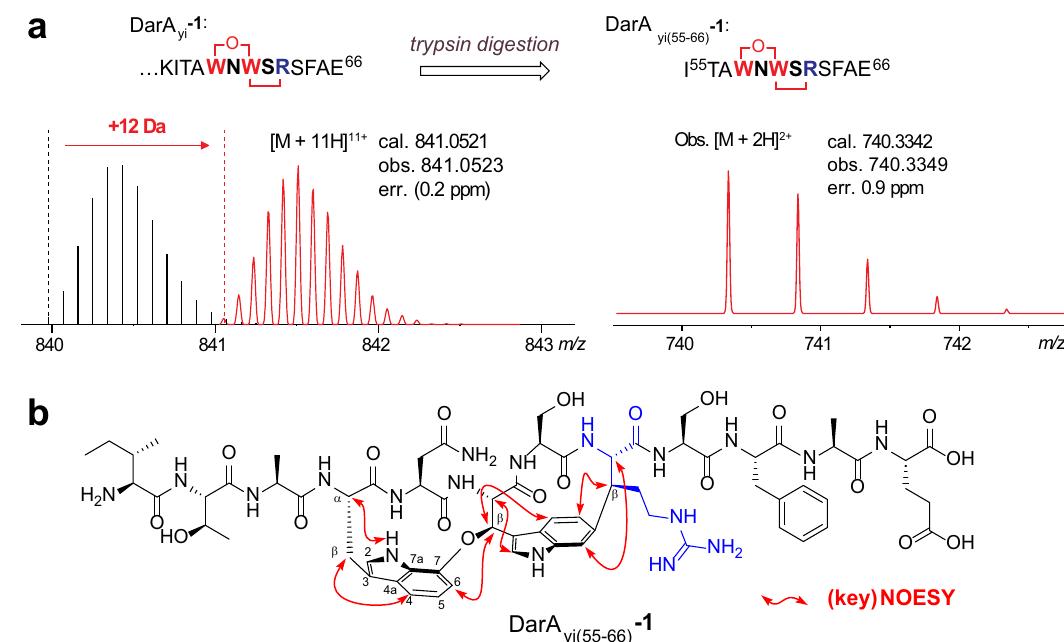
Fig. 6 An Arg-containing daropeptide from Yersinia intermedia . a HRMS analysis of the fully modi fi ed DarA yi (DarA yi -1 ) produced by coexpression of DarA yi with DarE yi . Similar to Fig. 1, the theoretically predicted signals corresponding to the unmodi fi ed DarA yi were shown for comparison. b The chemical structure of DarA yi(55-66) -1 , showing the key NOSEY correlation. See Supplementary Figs. 10 – 13 for the 1D and 2D NMR spectra and Supporting methods for